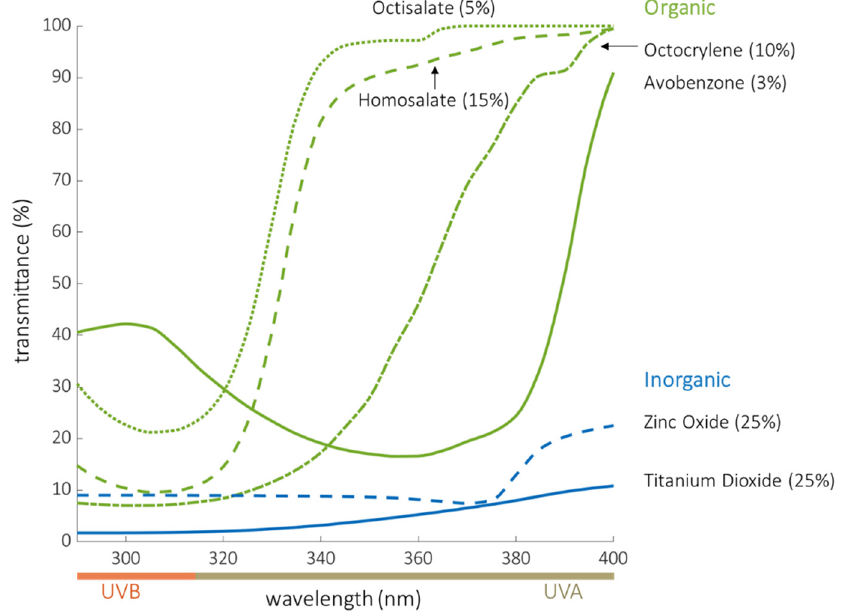
Figure 4. Transmittance of organic sunscreen filters (tested in this study) and inorganic sunscreen filters (ZnO and TiO 2 ). Data were obtained from the BASF sunscreen simulator [59] where the maximum concentration allowable by the FDA [46] was used to generate each curve.